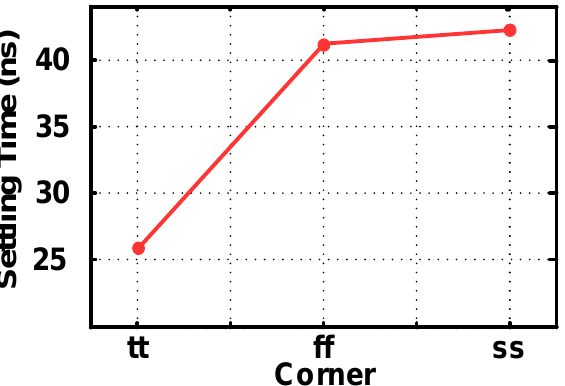
Figure 13. The settling time with corner change.